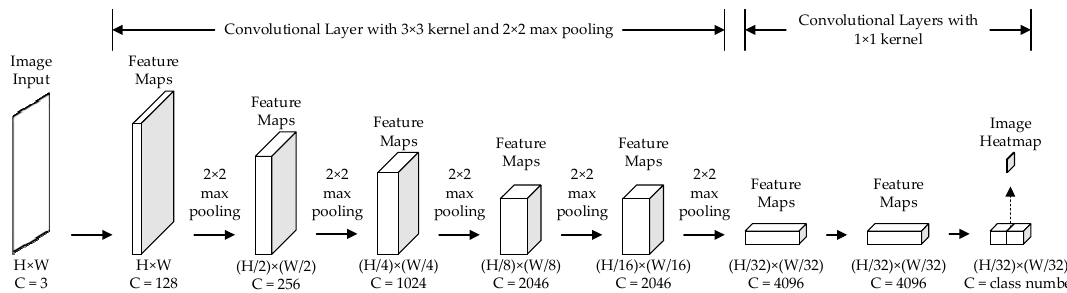
Figure 1. The procedure for creating heat maps based on FCN. H indicates the height of feature maps, W indicates the width of feature maps, and C indicates the channel number of the convolutional kernel. The heat maps cannot be directly used in semantic segmentation. The size of the heat maps has to be expanded to the same size as the input images. We used up-sampling to finish that process. Up-